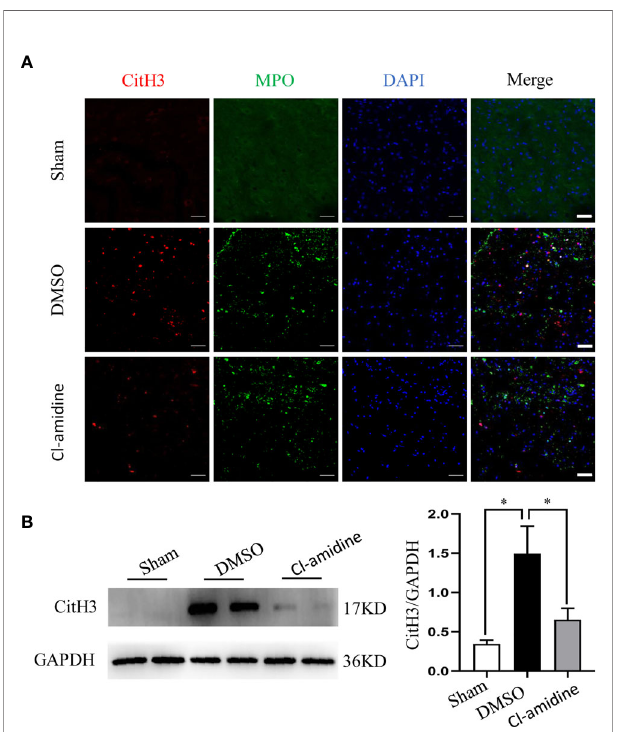
FIGURE 3 | DNase1 degrades NETs after SCI. (A) Representative images of CitH3 (red) and MPO (green) double-positive cells in spinal cord from each group at 24 h after operation. Nuclear was marked with DAPI (blue). Scale bars = 50 m m. (B) Representative immunoblots and quanti fi cation of the CitH3 levels in spinal cord of each group. GAPDH is used as a loading control. Data are presented as means ± SD of n = 9 (* p <